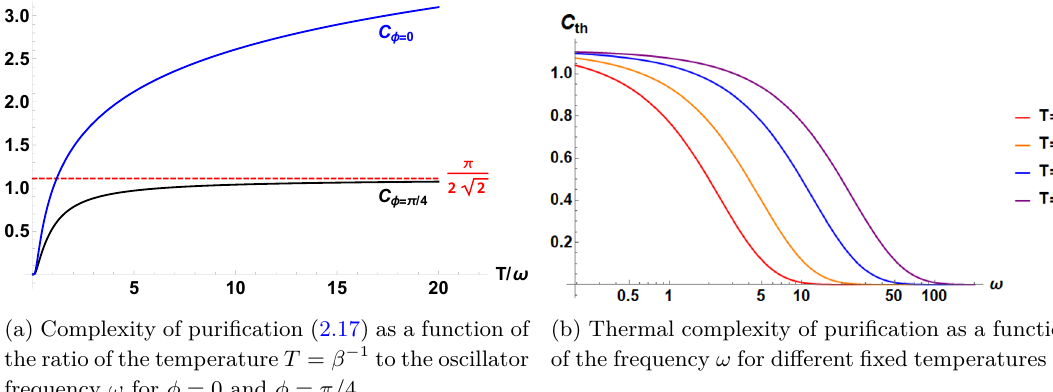
√ ≈ π/ (2 2) ≈ 1 . 1 , as seen in figure 2a. φ = π/ 4 drops off φ = π/ 4